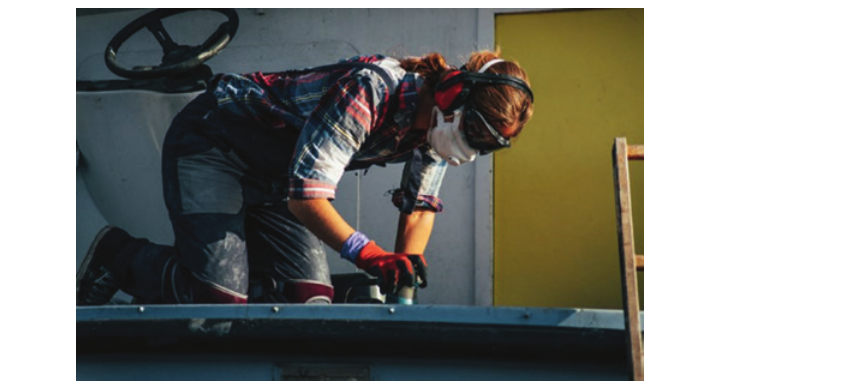
figure 5: Danielle Bjelic as Katie, behind the scenes of Lost Property (photograph: clement